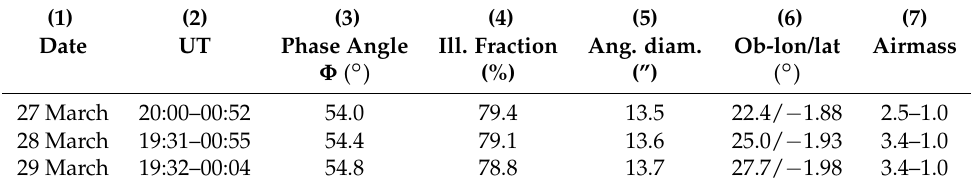
Table 1. Orbital geometry and circumstances of ground-based observations 27–29 March 2015: (1–2) Date/ UT interval; (3–5) disk aspect; (6) sub-observer longitude and latitude (planetocentric); (7) airmass.